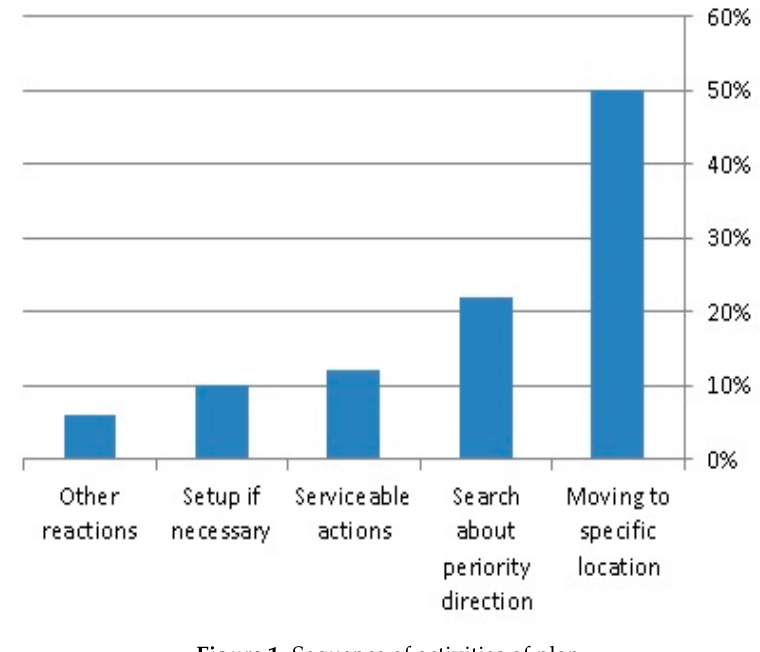
Figure 1. Sequence of activities of plan.